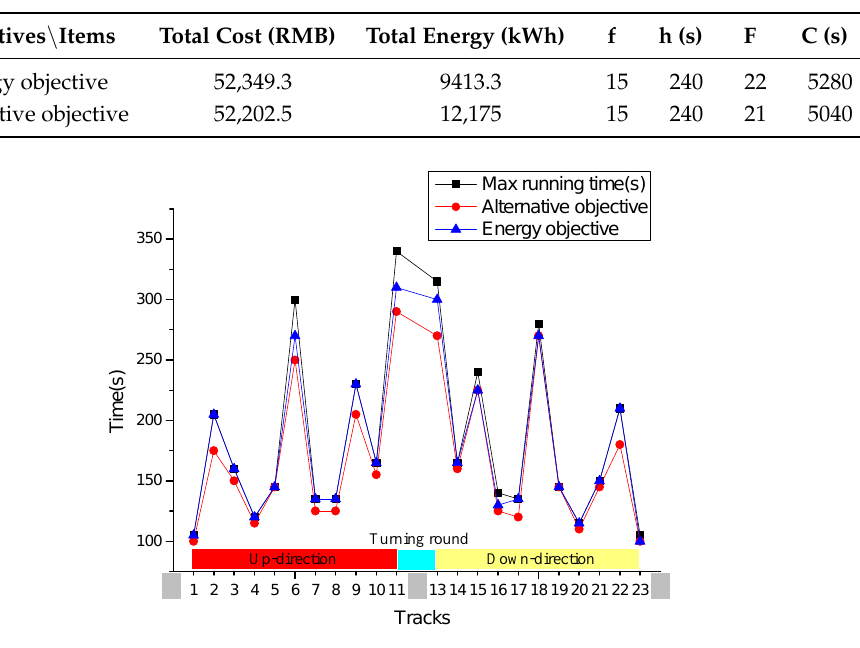
Figure 12. Travel time of od pairs under an energy consumption objective. Table 5. Result parameters with two different objectives.